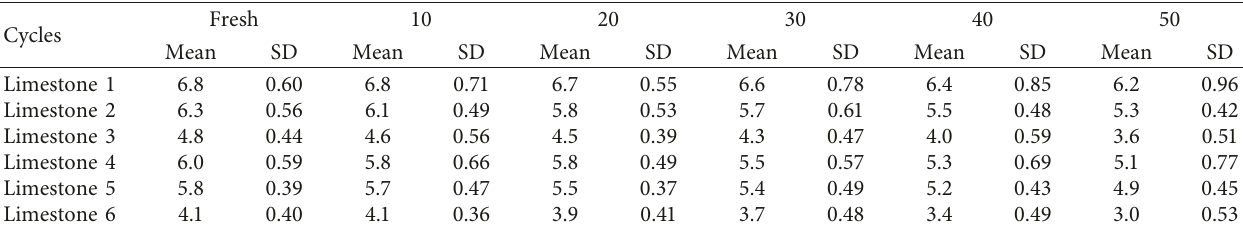
Limestone 5 74.0